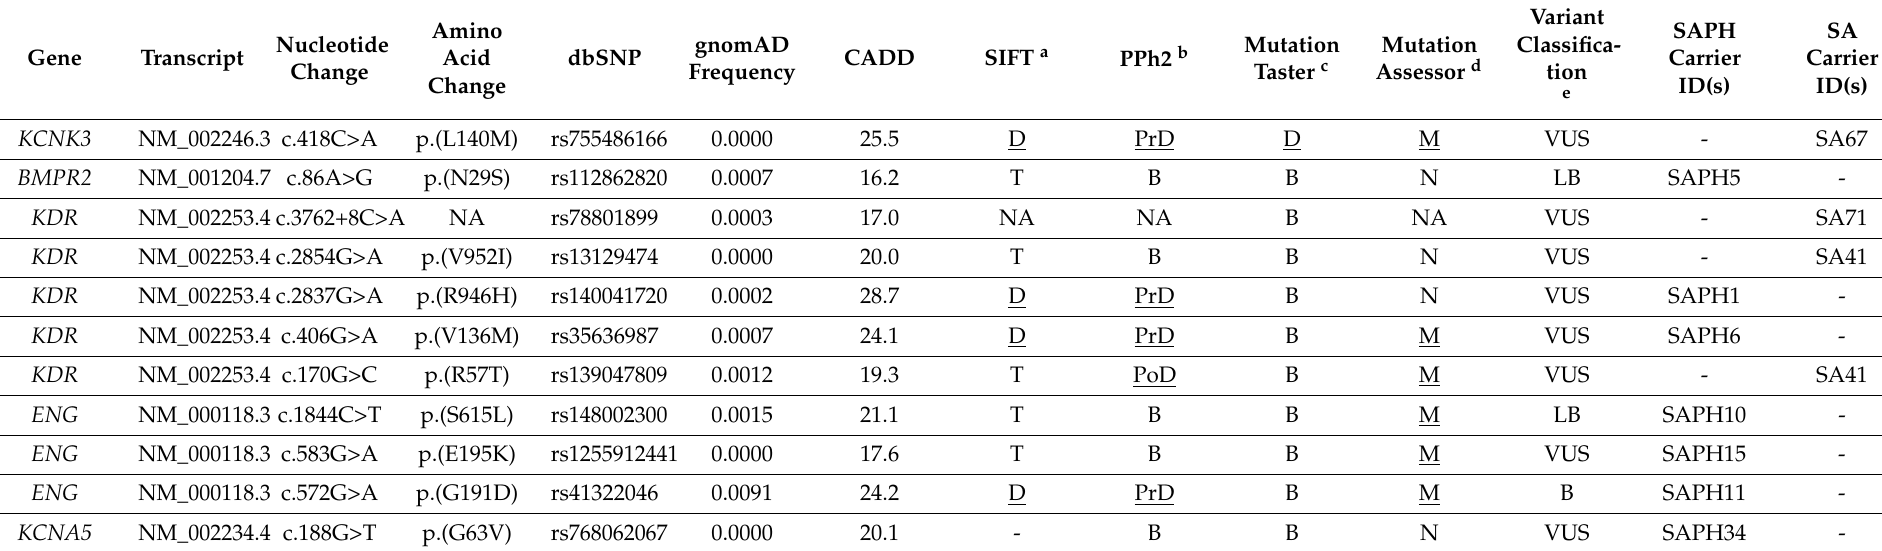
Table 2. Variants in the diagnostic gene panel (a) SIFT: T= Tolerated; D = Damaging; A = Activating; (b) PolyPhen-2: B= Benign; PrD = Probably Damaging; PoD = Possibly Damaging; (c) Mutation Taster: D = Deleterious; B = Benign; (d) Mutation Assessor functional impact: N= Neutral; L= Low; M= Medium; H= High; Predicted functional impact high or medium is predicted functional; low or neutral is predicted non-functional. Predictions by SIFT [18], PolyPhen-2 [19], Mutation Taster2021 [20], or Mutation Assessor [21] indicating deleterious consequences are underlined. Carriers are of European ancestry except SAPH6 and SA41 (Hindustan) and SA71 (African American). (e) Variant classification according to ACMG 2015 guidelines as provided by QCI; P = Pathogenic; LP = Likely Pathogenic; VUS = Variant of Uncertain Significance; LB = Likely Benign; B = Benign. NA = not